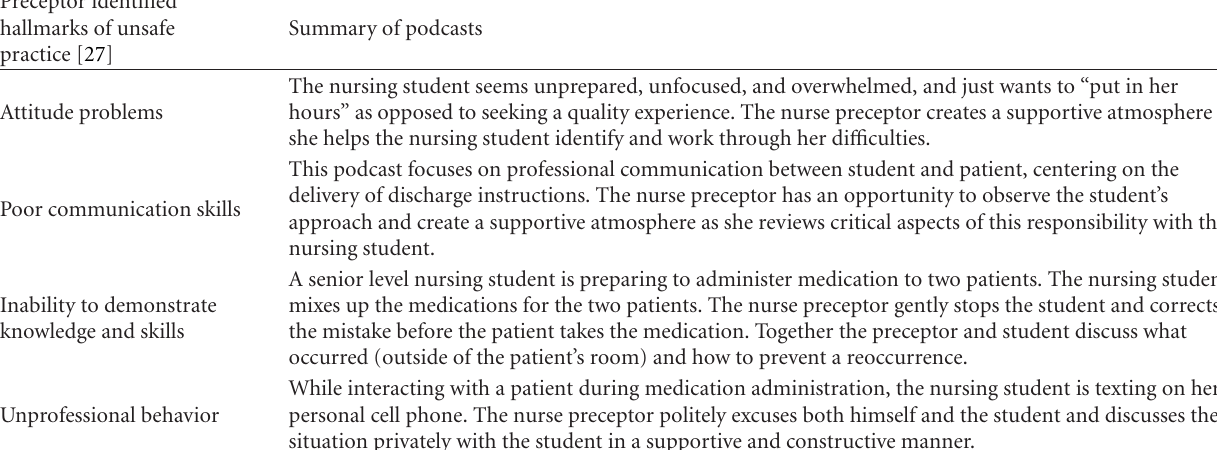
Table 1: Educational podcast